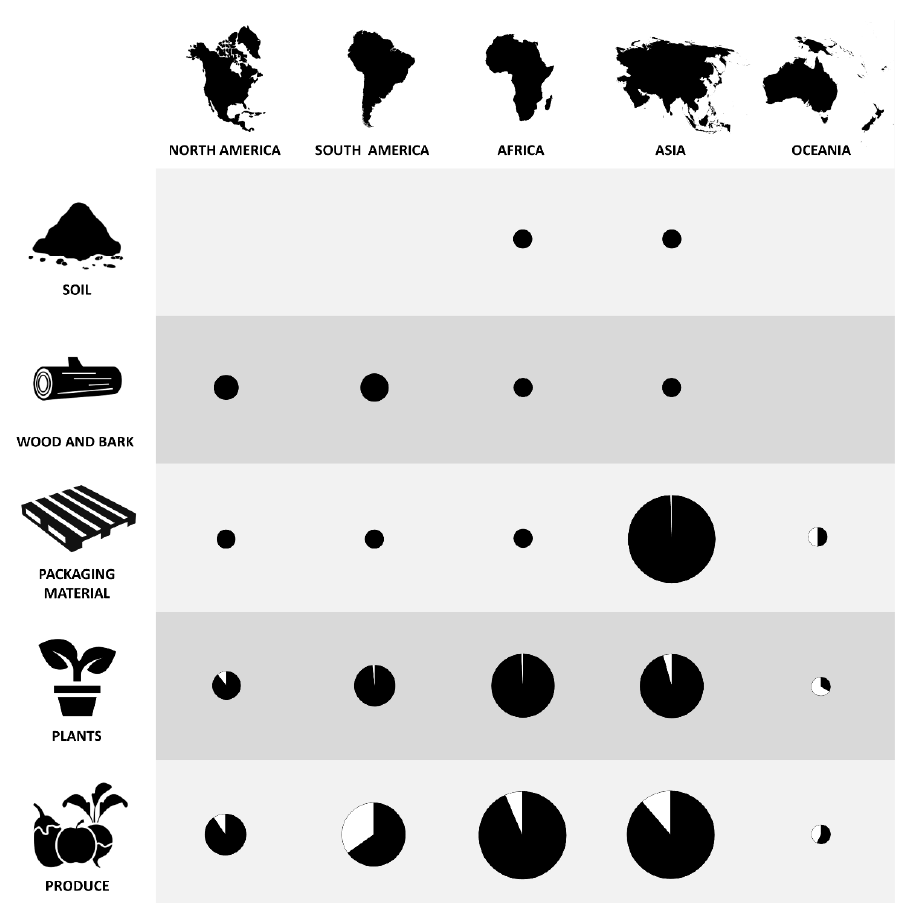
Figure 1. The frequency of fungus and insect interceptions at ports of entry in Europe in the 2016– 2020 period (data obtained from reports of Europhyt). Circle sizes indicate the relative amount of interceptions of IAPPs (fungi and insects) within each transport pathway according to their continents of origin. The black sector of the circle denotes the relative frequency of insect interceptions; the white indicates fungi interceptions. Legend: soil = soil and growing media; wood and bark = roundwood, bark, and processed wood; packaging material = wooden crates, wood pallets, wooden packaging material, dunnage; plants = plants for planting, scions, cuttings, leaves, flowers, branches with foliage; produce = fruits, vegetables, seeds.